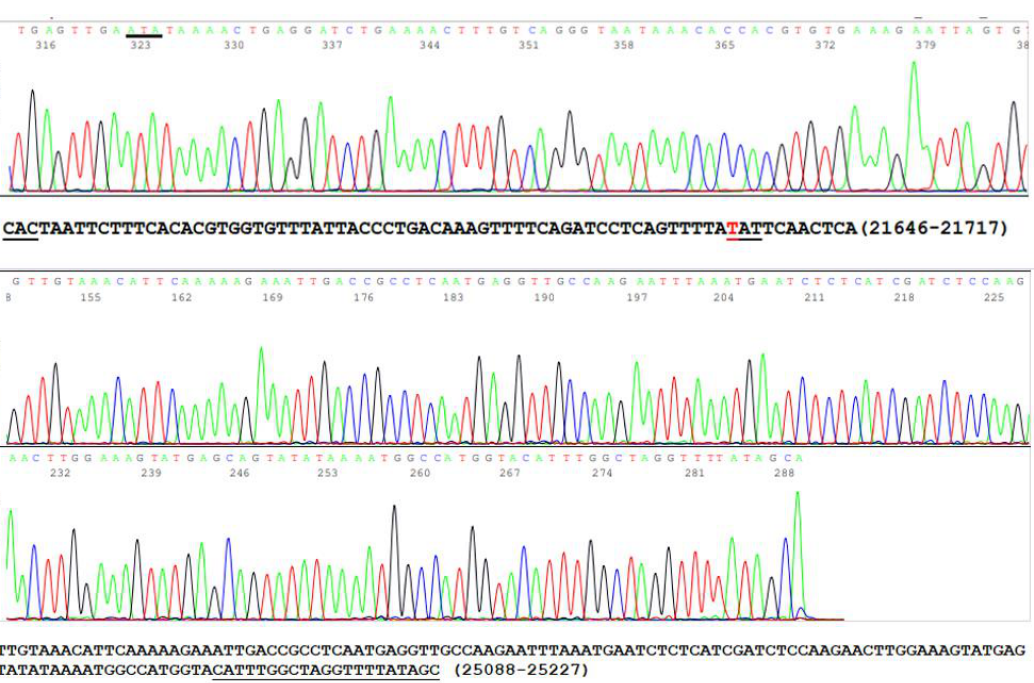
Figure 4. This is a figure showing two panels of sequencing electropherograms as evidence of intact S gene in a sample .